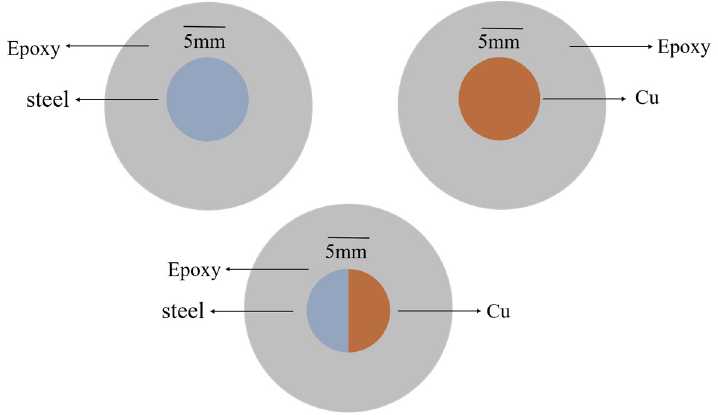
Figure 2. Schematic illustration of single steel, copper and coupled steel–copper electrodes used for electrochemical measurements. Table 2. Composition of the experimental soil (wt.%).